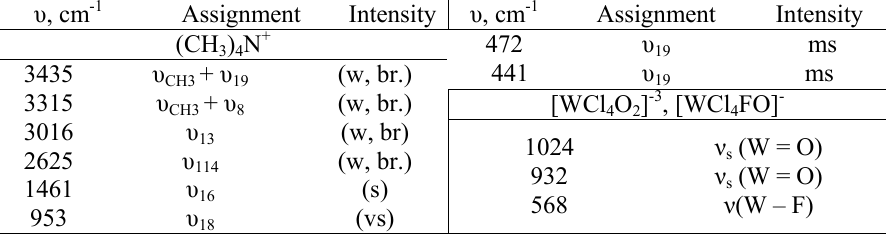
Table 2. The frequencies (cm -1 ) and assignment of cation and anion of compound